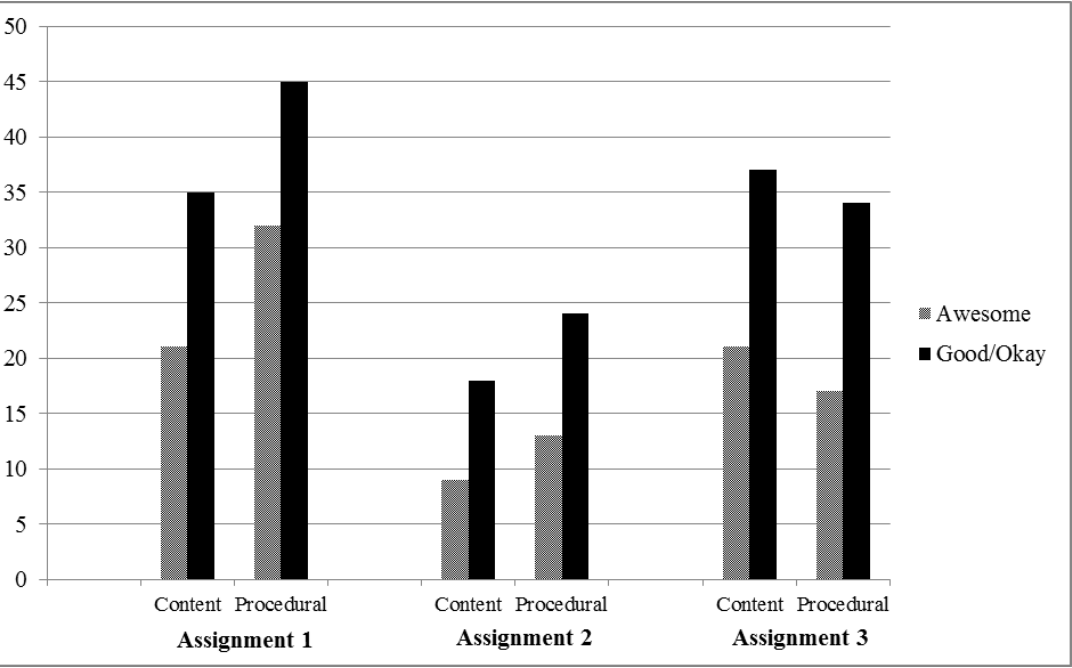
Figure 4 . Comparison of Content and Procedural Page Views Based on DropThought Response.